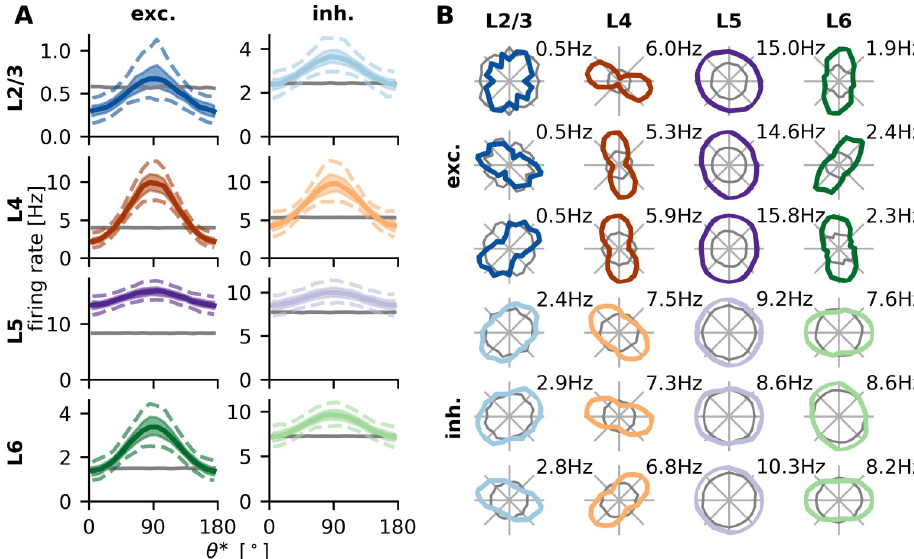
Fig 3. Single neuron tuning curves. A Single neuron tuning curves are centered at their respective preferred orientation and then binned over angles (bin size 10˚). 5%, 25%, 50% (median), 75% and 95% percentiles are then calculated for each bin independently and plotted using different line styles. Gray lines indicate median firing rates in the spontaneous condition. B Sample tuning curves from each population in polar representation. Gray lines indicate rates of the same neuron in the spontaneous